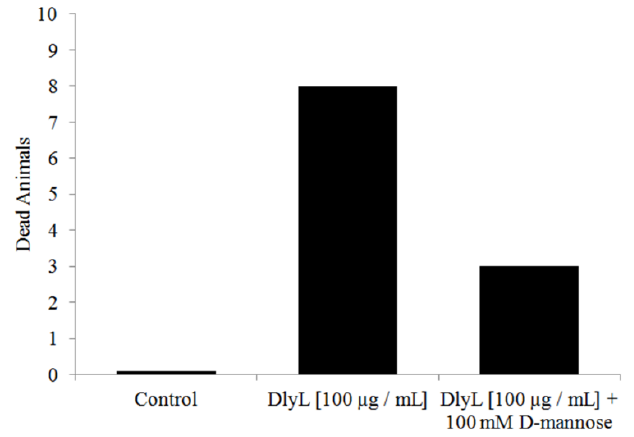
Figure 6. Toxic effect of DlyL (100 µg/mL) and DlyL (100 µg/mL) previously incubated with 100 mM D -mannose.